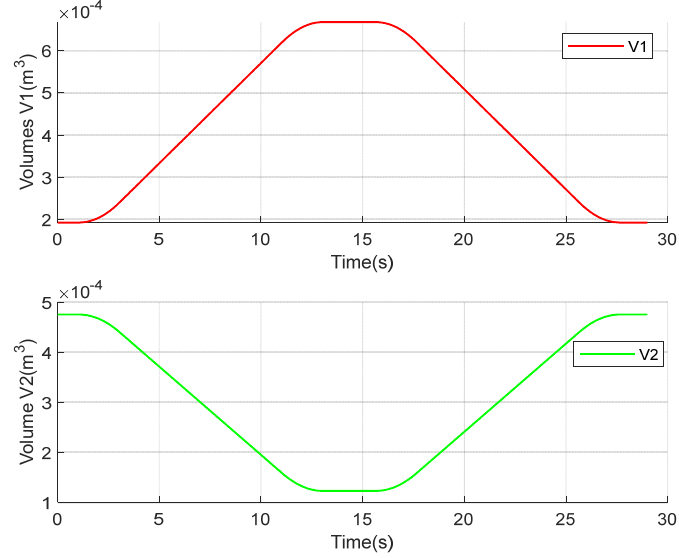
Figure 7. The position and velocity of the rolling diaphragm.